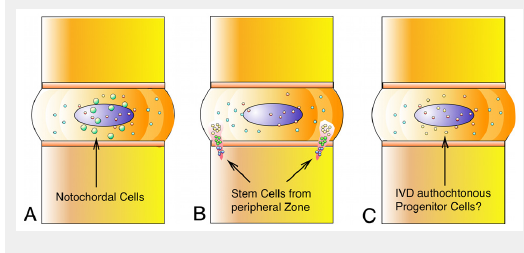
A. Three niches for stem cell-like progenitor cells (SCLC) in the intervertebral disc (IVD): A. Notochordal cells with regenerative capacity remain persistent in the IVD at different ratios and at different stages in the lifetime (according to [47, 50, 51]). B. The perichondrium region (PR) close to the outer annulus fibrosus acts as a densely packed center where cells migrate out of the PR with 2 zones of interest: perichondrium region of interest 1 (P roi 1) with densely packed cells (red) and perichondrium region of interest 2